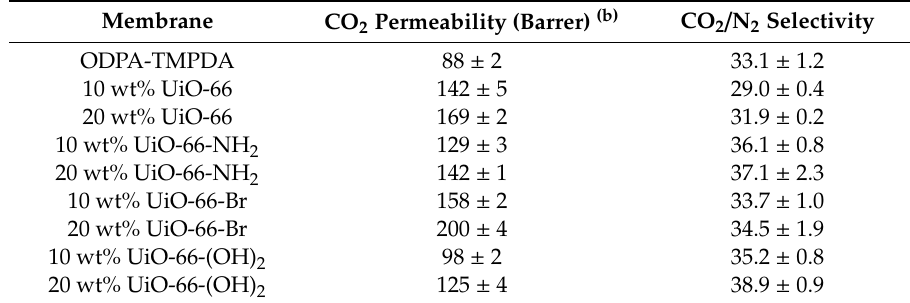
Table 2. Permeation results of the membranes at 35 ◦ C at the feed pressure of 1 bar (or 10 5 Pa) CO 2 / N 2 mixture (20 vol% / 80 vol%) (a) .